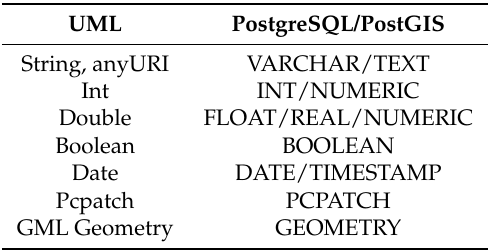
Table 2. Data type